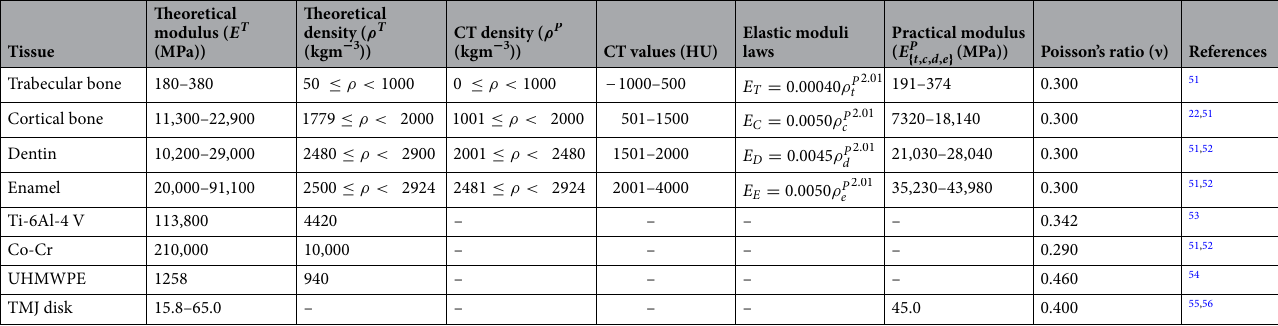
for each biological material. Different power laws were computed for trabecular bone . Each law was adjusted to produce a range of in-vivo elastic moduli in agreement with literature values. The range of elastic properties was assigned as follows. The elastic moduli for trabecular bone